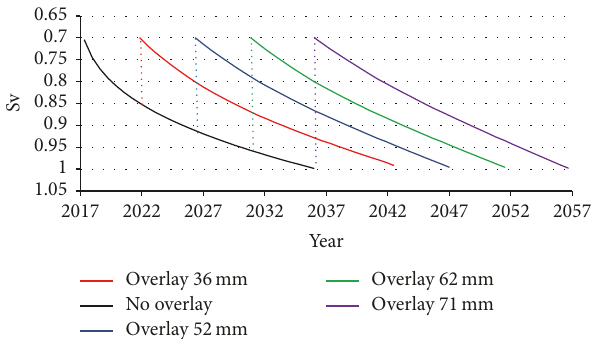
Figure 6: Overlay design and timing of four rehabilitation scenar- ios: Sv and life cycle relation.